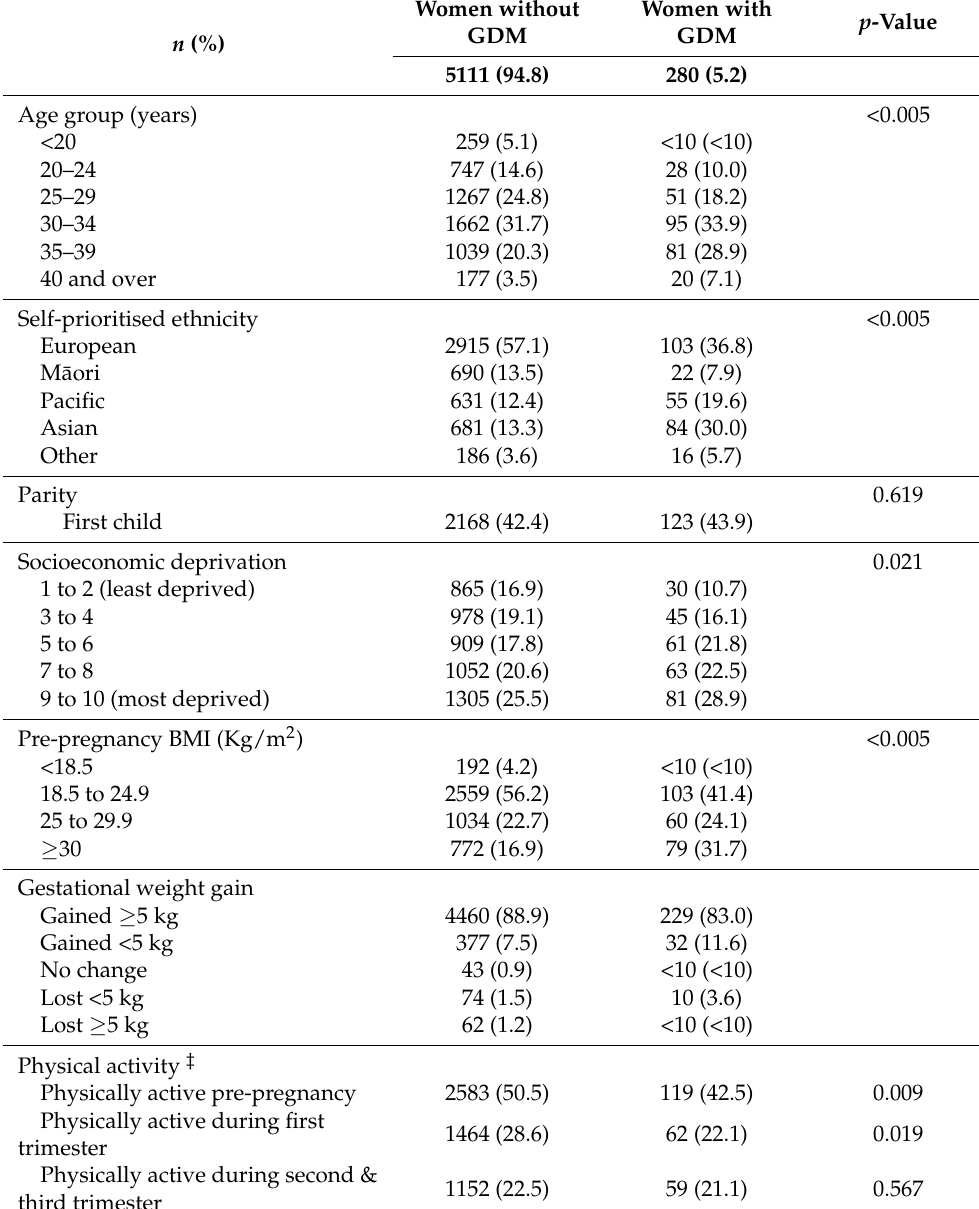
Table 1. Characteristics of women in the Growing Up in New Zealand cohort according to gestational mellitus (GDM) diagnosis †